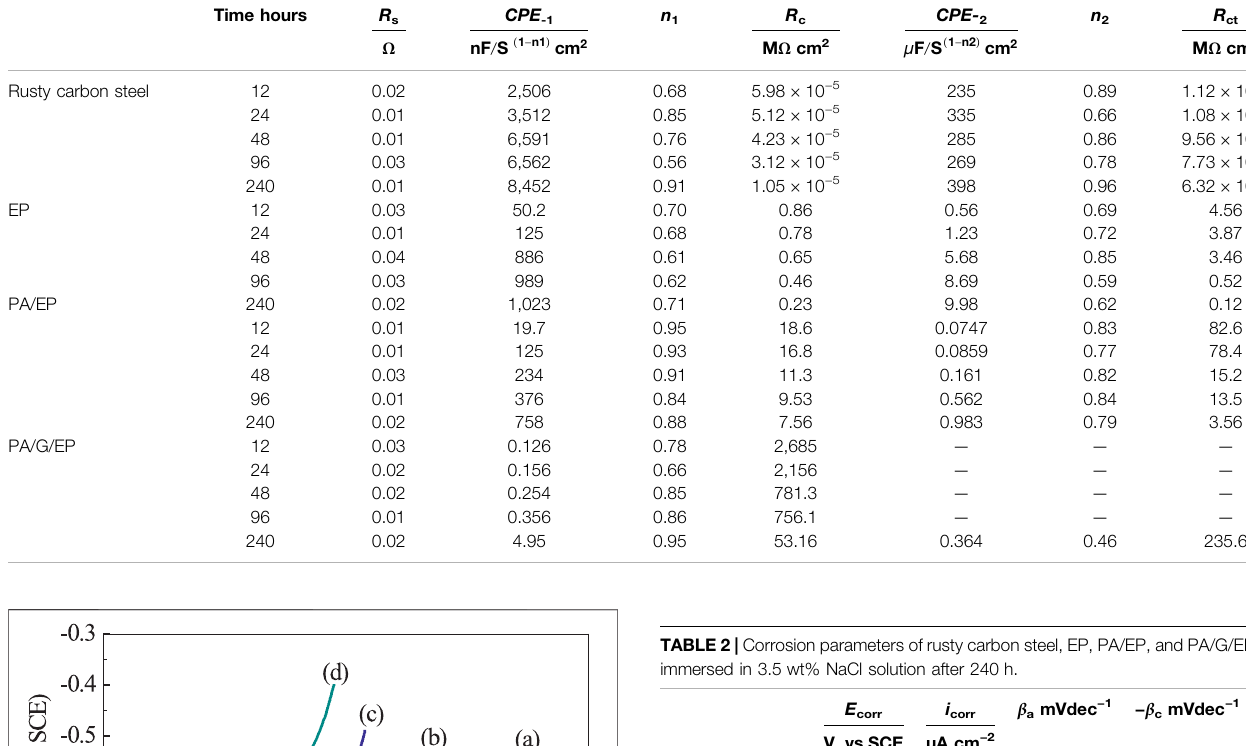
TABLE 1 | Electrochemical corrosion parameters fi tted from the equivalent circuit.